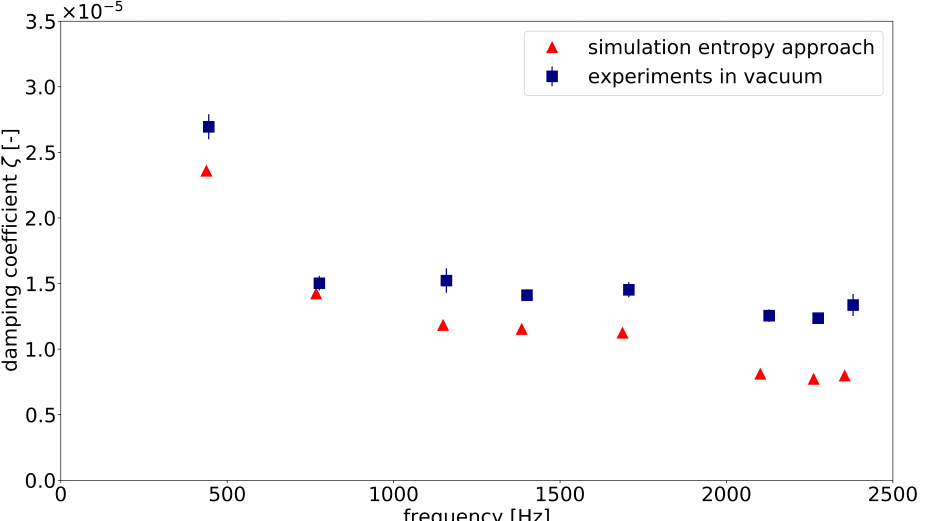
Figure 8. Comparison of the experimental data and the damping coefficient determined by the entropy approach for the box